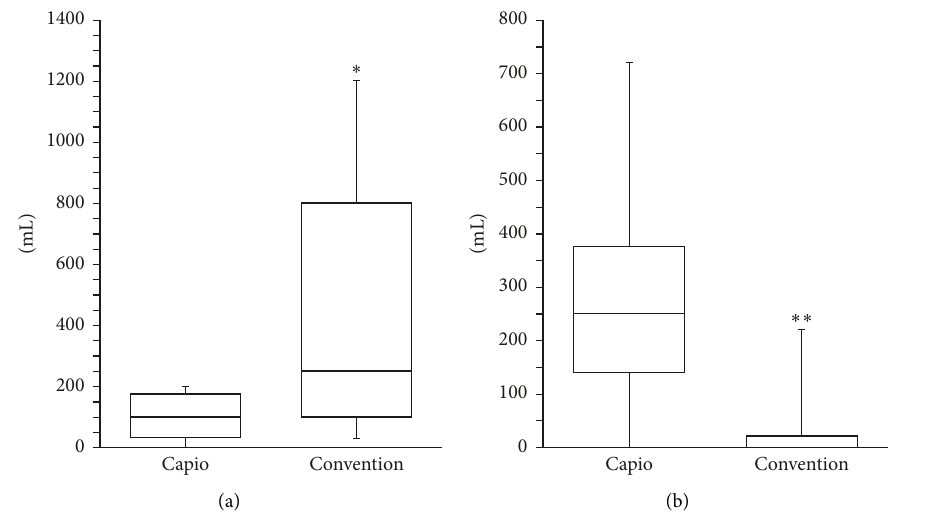
Figure 1: Comparison of the first voiding volume (a) and residual urine volume (b) after removal of the urethral catheter on the second postoperative day in women who underwent a TVM procedure using the Capio device or conventional TVM surgery. ∗ P < 0 . 05 and ∗∗ P < 0 . 01 versus the Capio TVM group. TVM, tension-free vaginal